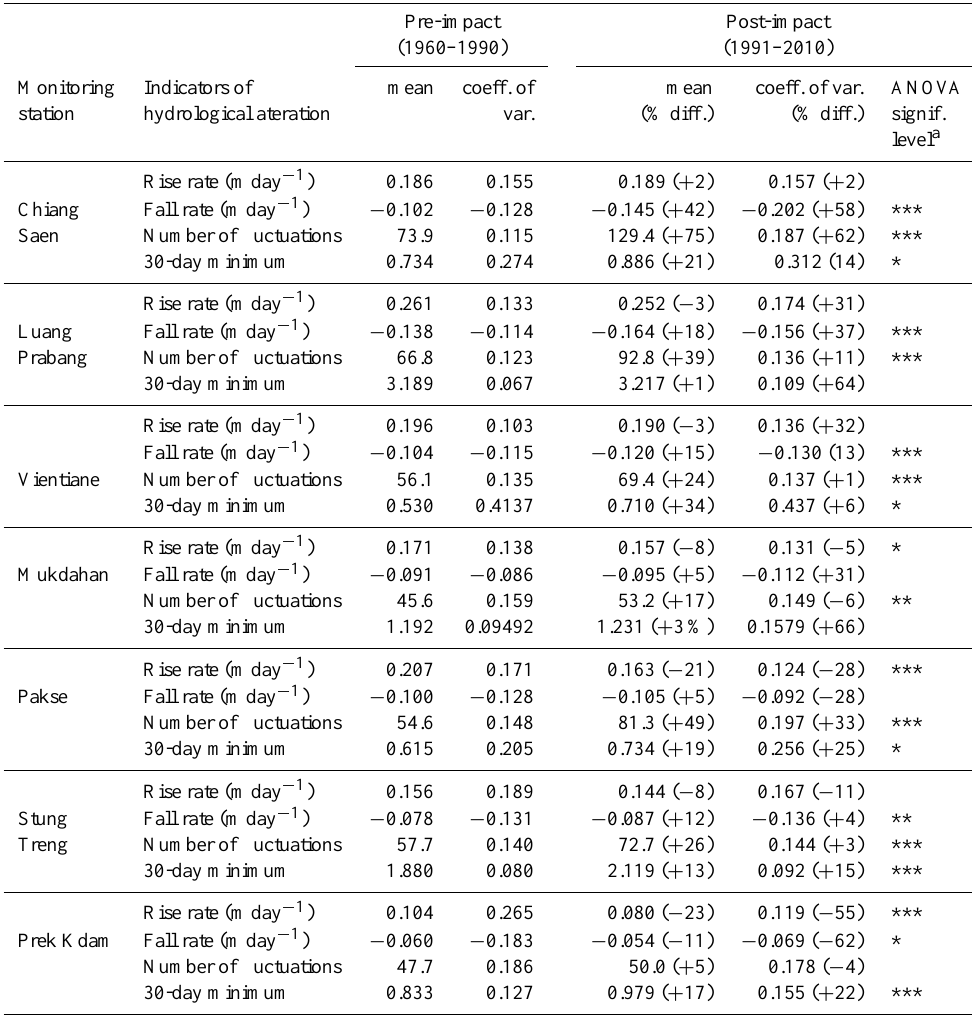
Table 4. Hydrological alterations of selected indicators for pre- and post-1991 periods along the lower